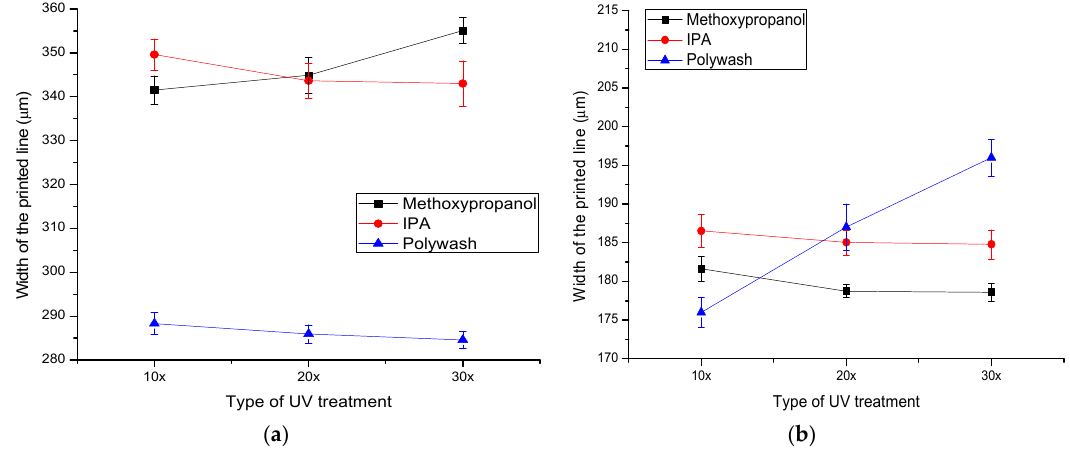
Figure 18. Width of the lines printed by modified photopolymer plates: ( a ) 0.2 mm positive, ( b ) 0.2 mm negative.